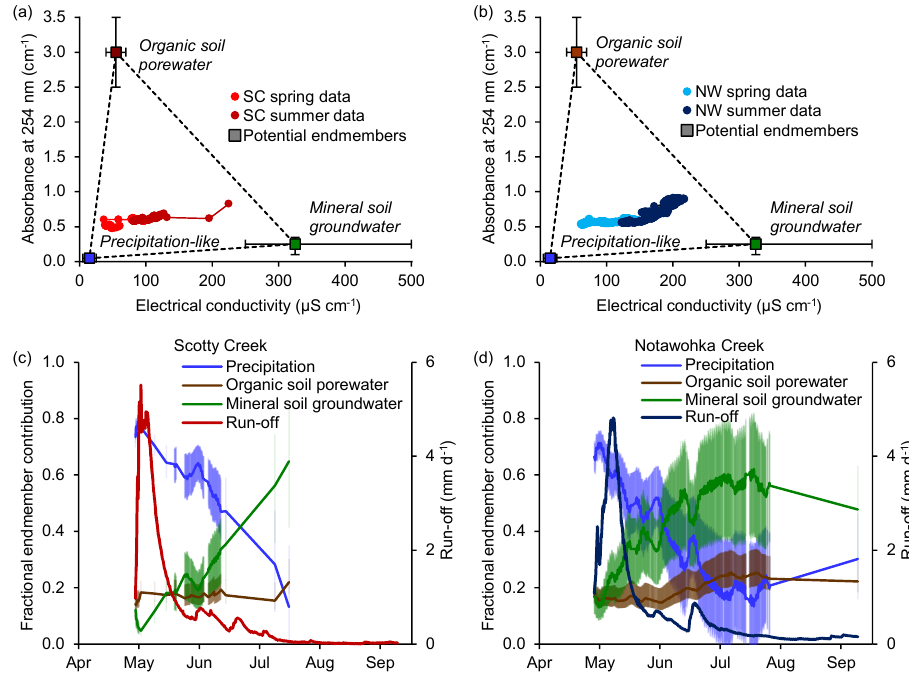
Figure 6. Endmember mixing space defined by decadal absorbance at 254nm and electrical conductivity with outlet stream data from (a) Scotty Creek and (b) Notawohka Creek, as well as the fractional contribution to streamflow from potential endmembers at (c) Scotty Creek and (d) Notawohka Creek catchment outlets. Error bars in (a, b) indicate the 95% CI of the endmember characteristics (see Sect. 2 for justification), while error bars in (c) and (d) indicate the 95% CI for fractional endmember contribution to streamflow based on Eqs. (1)–(3) and the uncertainty in the endmember